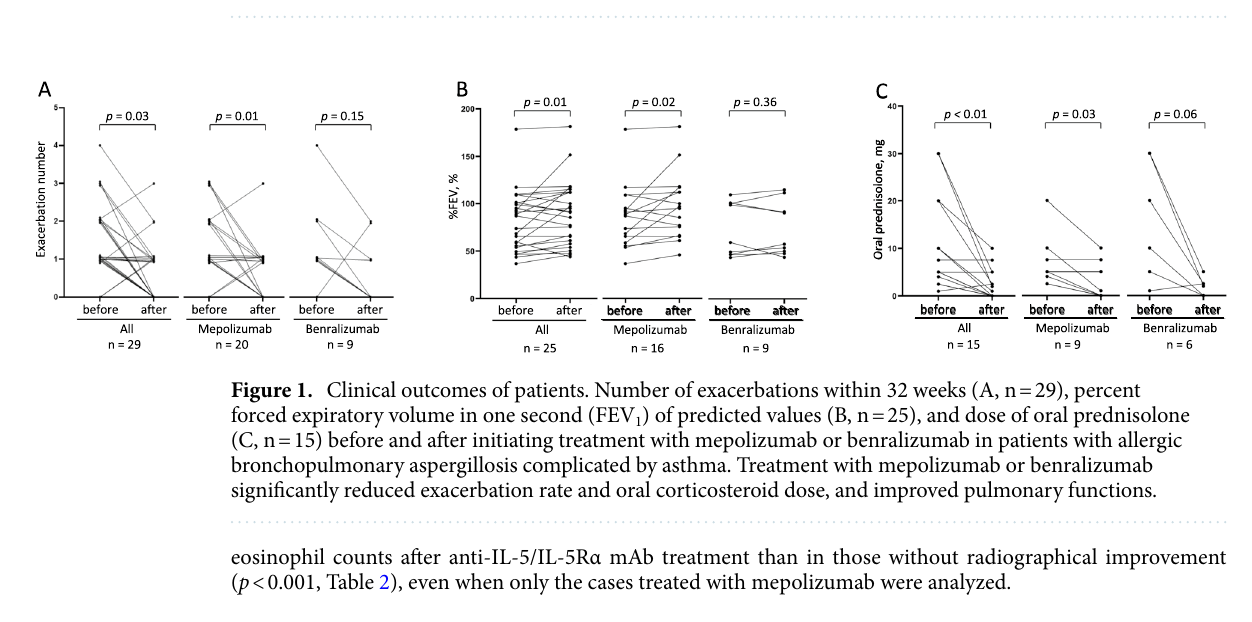
Table 1. Demographic data of the study subjects. Values are represented as the median (interquartile range) or n (%).